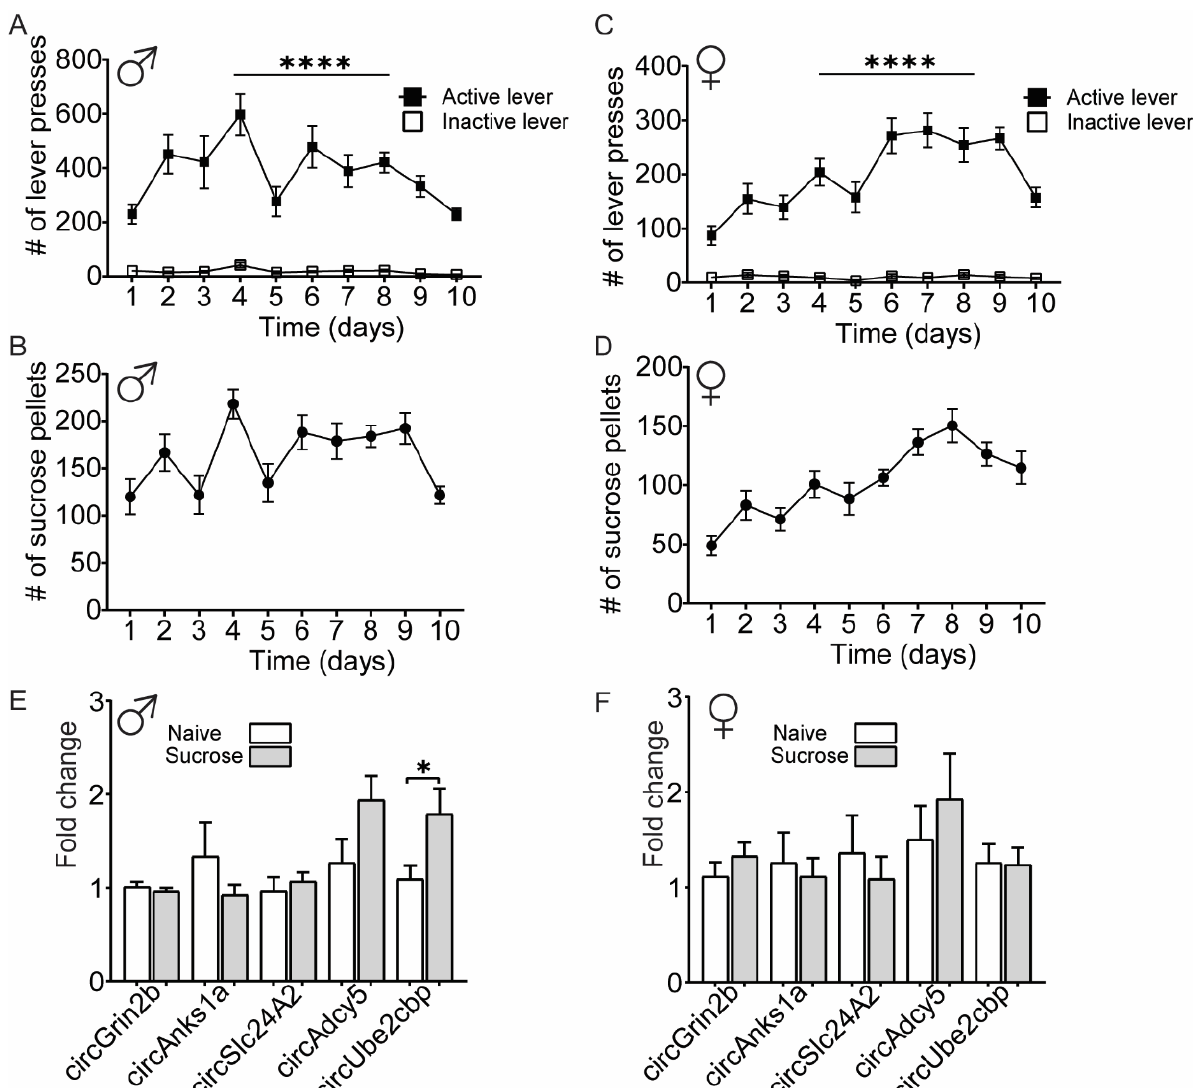
Figure 5. The heroin-associated circRNA circUbe2cbp is similarly regulated by sucrose self- administration in the male OFC. ( A – D ) Sucrose self-administration data for male ( A , B ) and female ( C , D ) animals. Shown are average lever presses ( A , C ) and number of sucrose rewards received ( B , D ) N = 18 males, 17 females. ( E , F ) qPCR measurement of validated heroin-associated circRNAs in male ( E ) and female ( F ) animals that self-administered sucrose or were exposed to the self-administration chamber (naïve). Error ± SEM. * p < 0.05; **** p < 0.0001.